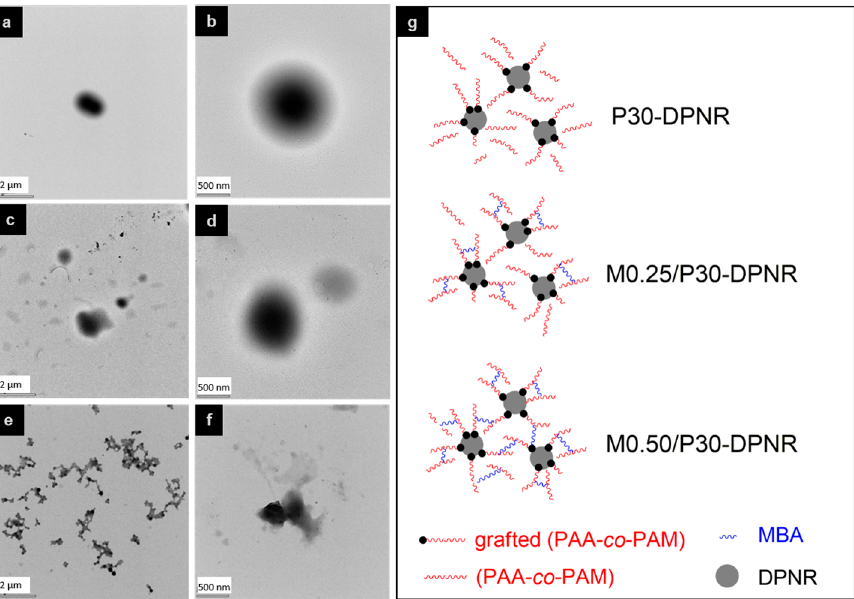
Figure 2. TEM images of ( a , b ) P30-DPNR, ( c , d ) M0.25/P30-DPNR and ( e , f ) M0.50/P30-DPNR, and ( g ) schematic representation of the formation of crosslinked (PAA- co -PAM)-DPNR.